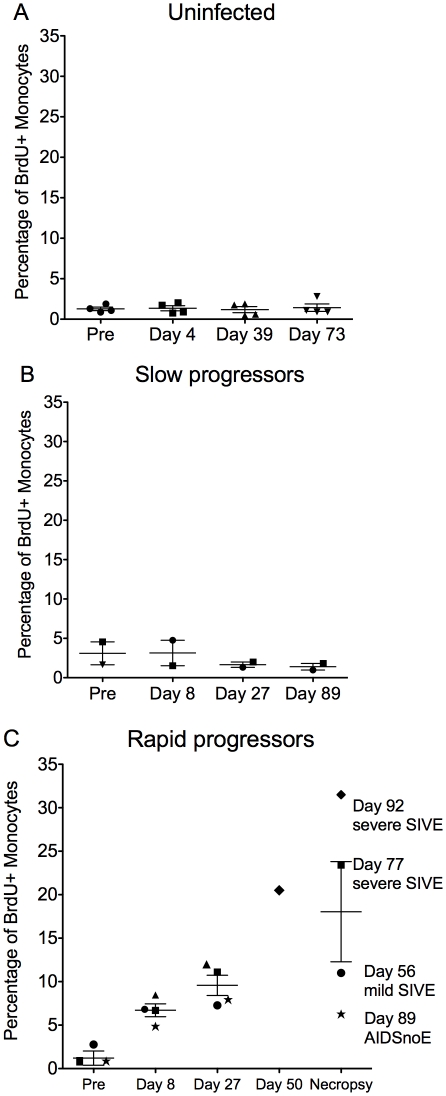
Increased percentage of BrdU+ monocytes is predictive rapid progression to AIDS and severity of SIVE.(A–C): BrdU was injected prior to (n = 1) and after SIVmac251 infection (n = 3) and the percentages of BrdU+ monocytes 24hrs after BrdU injection was determined by flow cytometric analysis. A. In four uninfected CD8+ T lymphocyte depleted animals, the percentage of BrdU+ monocytes remained approximately 2% of total monocytes in all time points. Thus, CD8+ T lymphocyte depletion alone without SIV infection does not alter monocyte turnover (n = 4). CD8+ T lymphocyte depleted SIV infected animals were divided into two groups: slow progressors (B) and rapid progressors (C). B. Monocyte turnover is unchanged at all points examined after infection in slow progressors (n = 2). C. The percentages of BrdU+ monocytes increased dramatically with rapid disease in animals that succumbed to AIDS (n = 5). The magnitude of BrdU+ incorporation of monocytes at necropsy can differentiate mild and severe SIVE. Each animal is represented by a different symbol. Error bars are standard error of the mean.